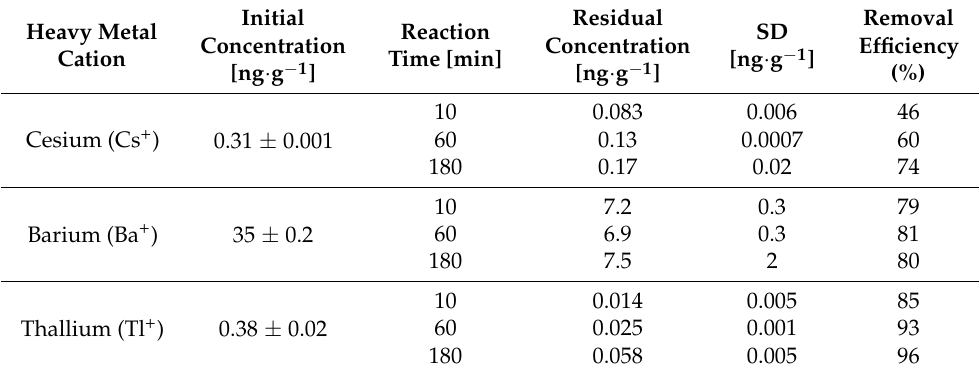
Table 14. Adsorption kinetics of different heavy metal cations for NPCT2 in non-contaminated non-carbonated mineral